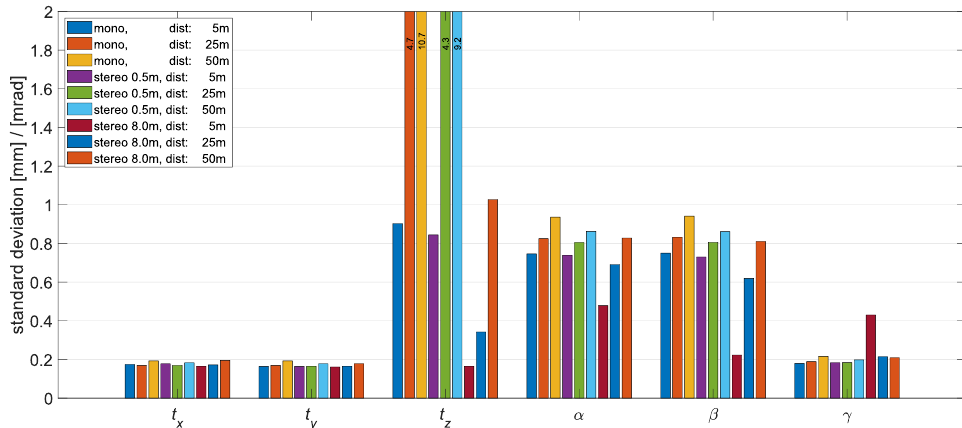
Figure 7. Standard deviations of the object pose from the Monte Carlo simulation over the different recording configurations. Simulated was the 20.4MP sensor, with a focal length of 25mm, and a 2m × 1.5m × 0.5m